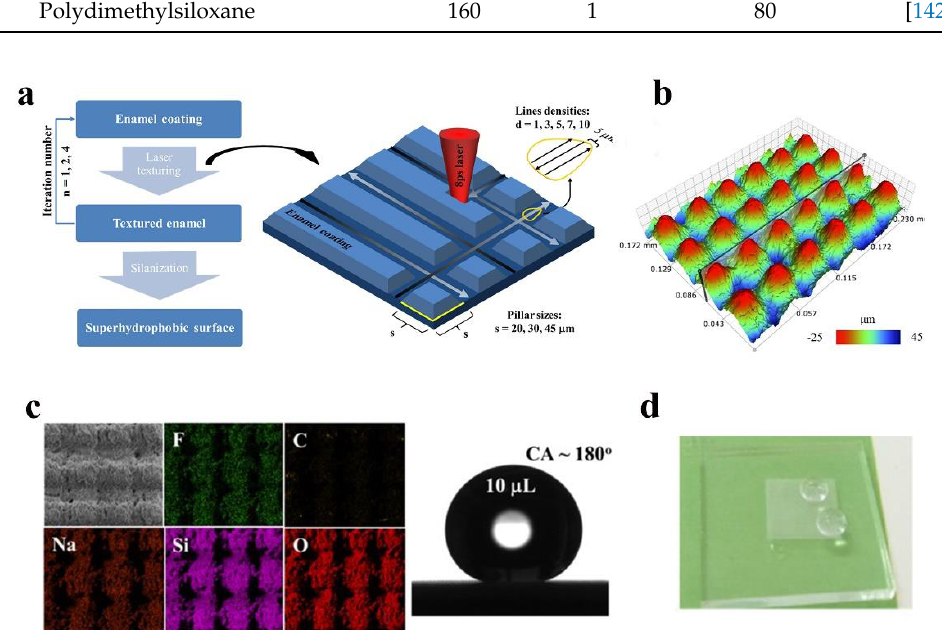
Figure 11. ( a ) Schematic diagram of laser etching, ( b ) 3D structural morphology of the glass surface. ( c ) Element distribution and contact angle of the glass surface, reproduced with permission from Ref. [129]. ( d ) The superhydrophobic surface after laser machining, reproduced with permission from Ref. [148].